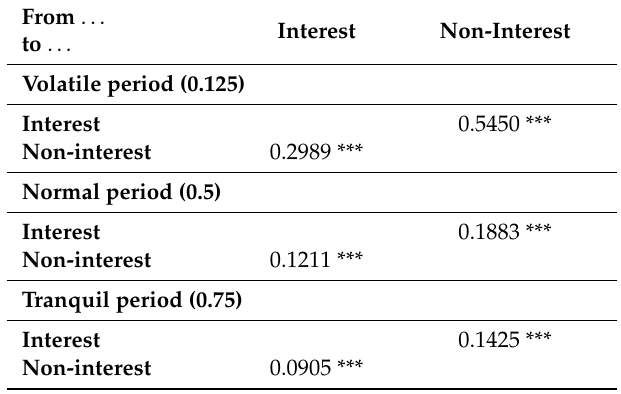
Table 7. Spillover coe ffi cients of the SDSVaR model, based on the banks’ income source. From ...